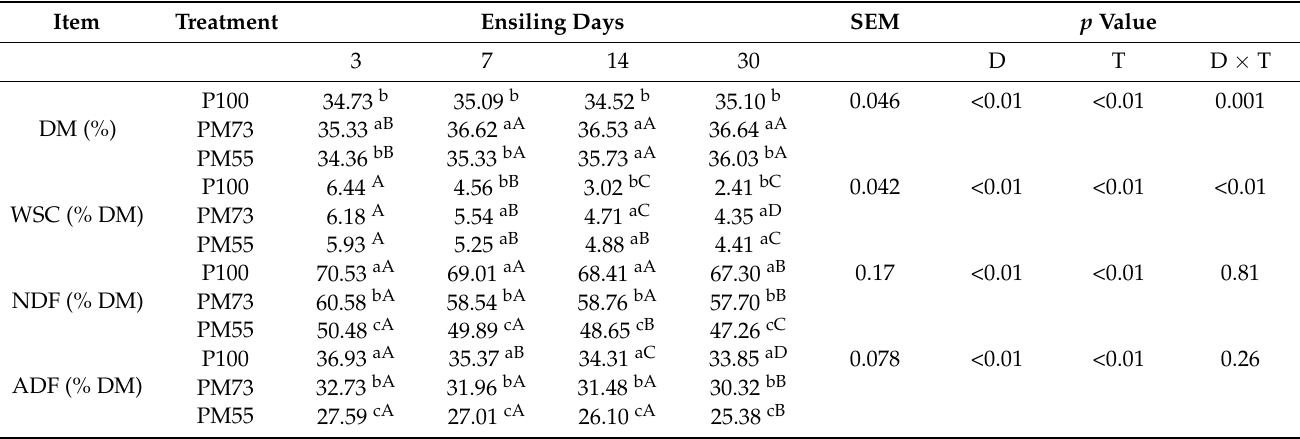
Table 2. The chemical composition of mulberry leaves and hybrid Pennisetum